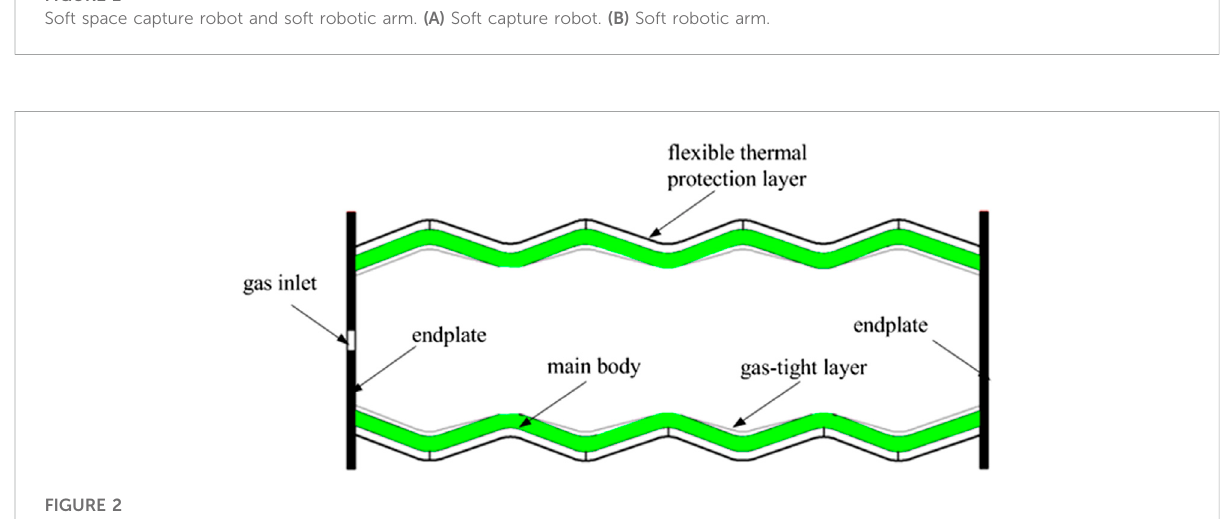
FIGURE 2 Pneumatic extensible